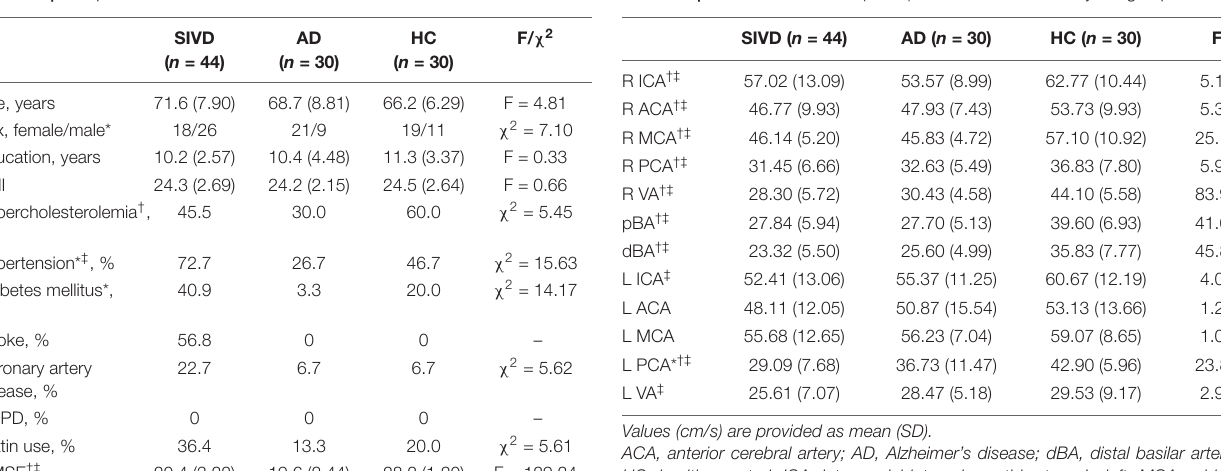
TABLE 1 | Group characteristics. TABLE 2 | Mean flow velocities (MFVs) of insonated arteries by the